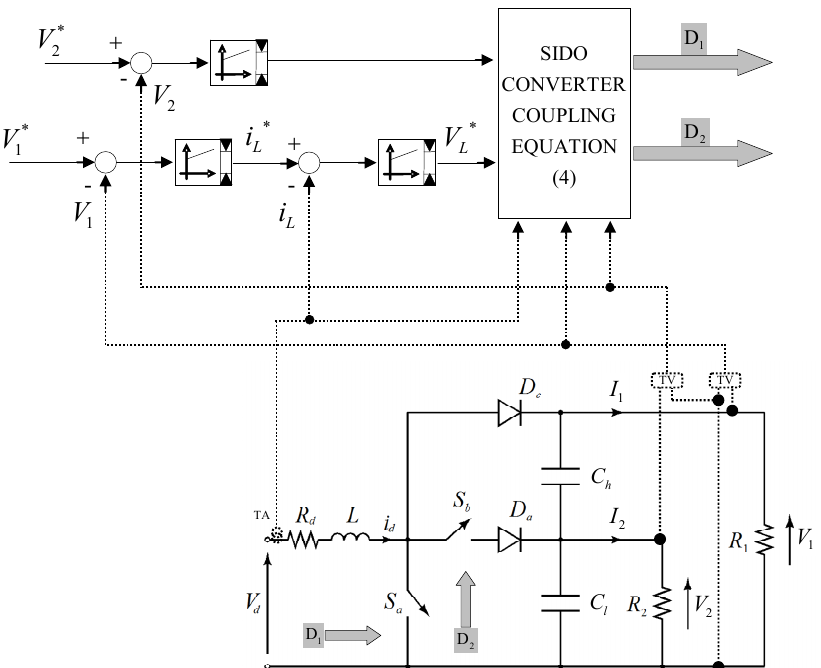
Figure 9. SIDO converter control